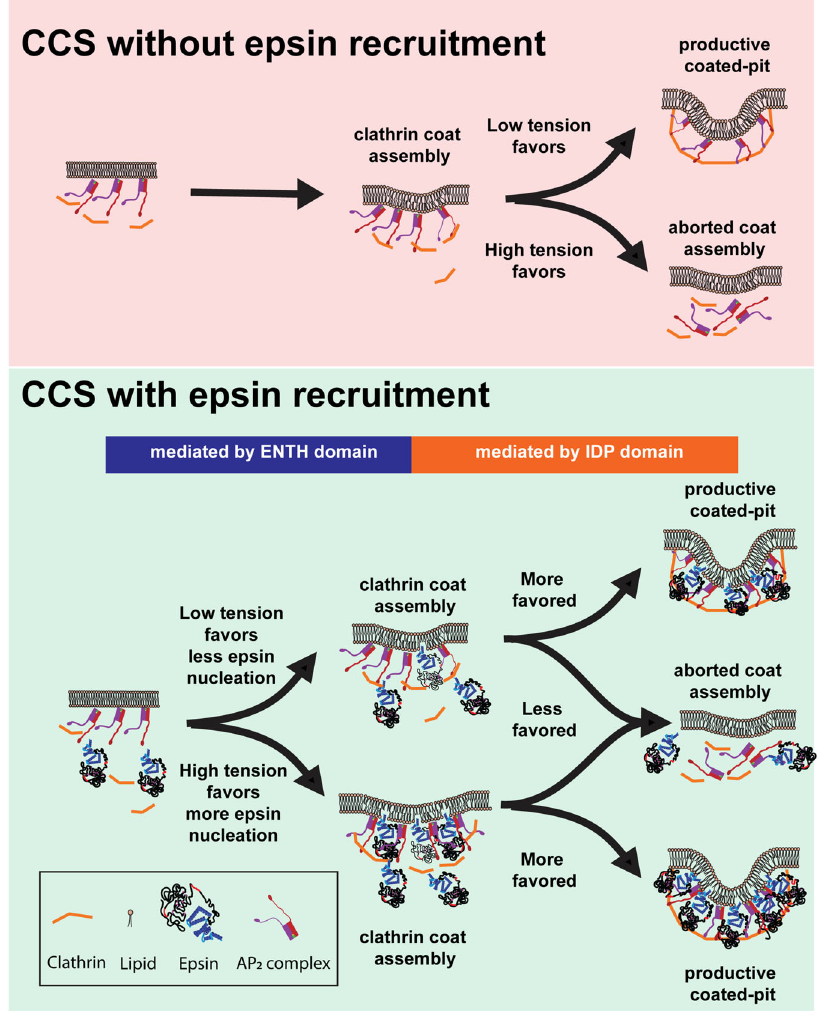
Fig. 7 Summary of the role of epsin in CCS formation under different tension environments. Epsin provides enhanced CCS stability compared to CCSs without epsin. At high tension, more epsin molecules are recruited to counteract elevated tension and to provide stability to CCSs. The AP2 and clathrin binding of epsin primarily impart the additional stability to coated pits by anchoring constituents of the CCS complex